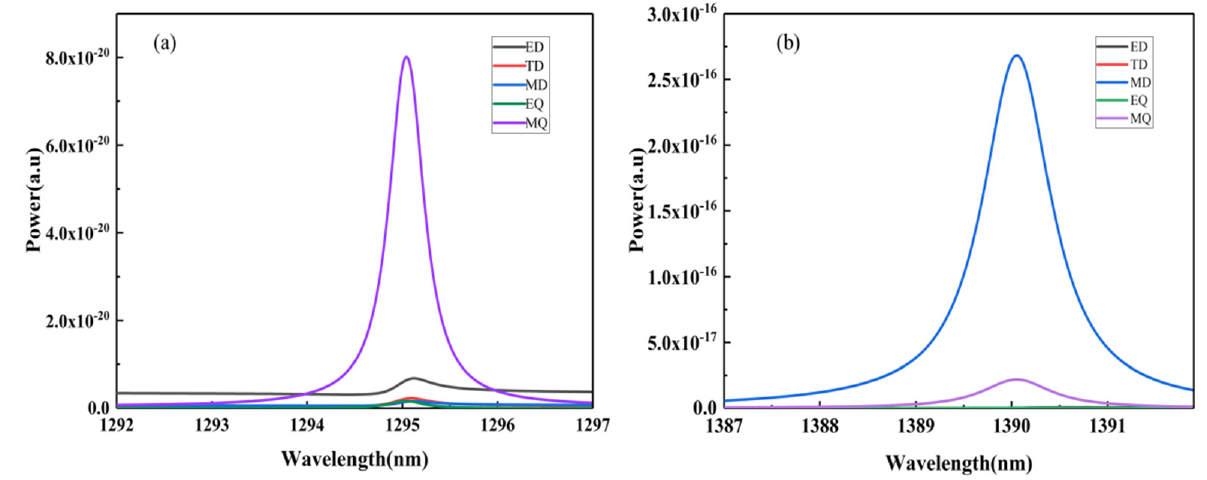
Figure 8. Radiant energy of each multipole resonance mode at ( a ) F2, and ( b ) F3.